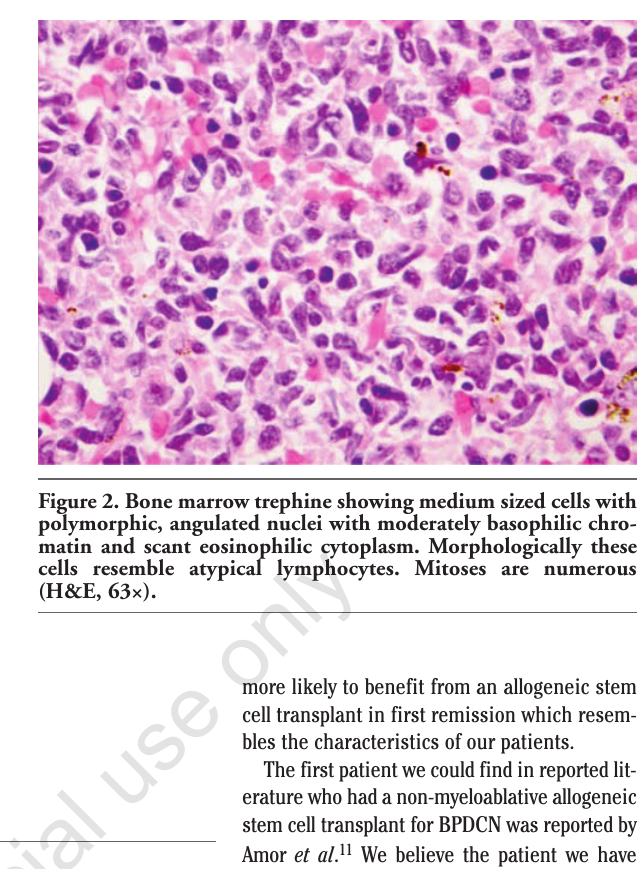
Figure 1. Bruise-like lesion on left side of thoracic vertebrae.